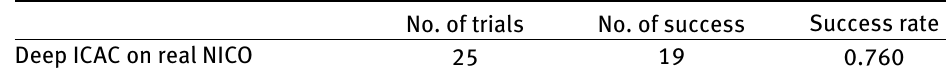
Table 3: Test results of running Deep ICAC using the networks trained on the real